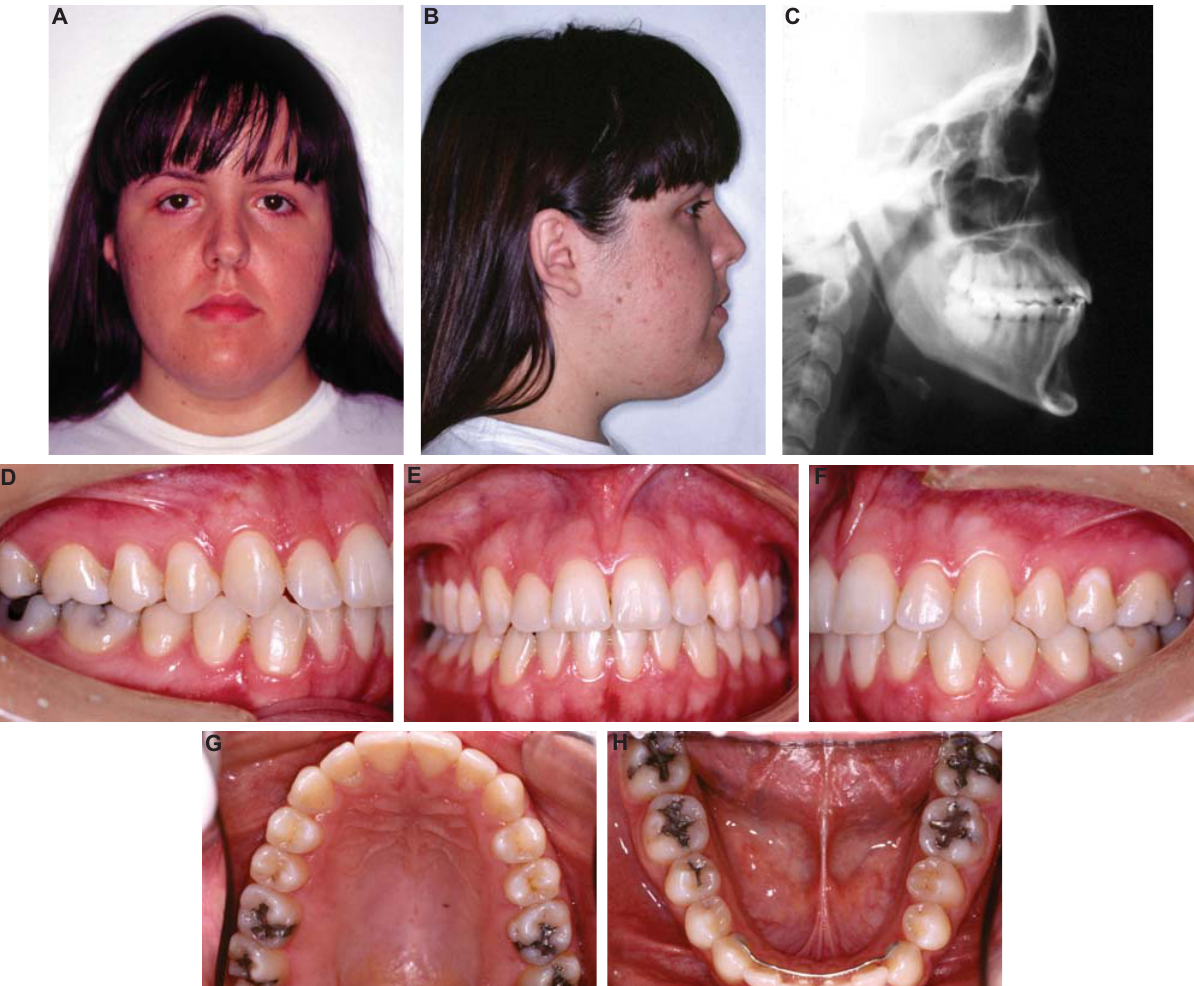
Figure 7- First follow-up appointment photographs. Extraoral (A and B) and intraoral (D-H). Lateral cephalograms (C) (parents authorized the publication of these pictures)